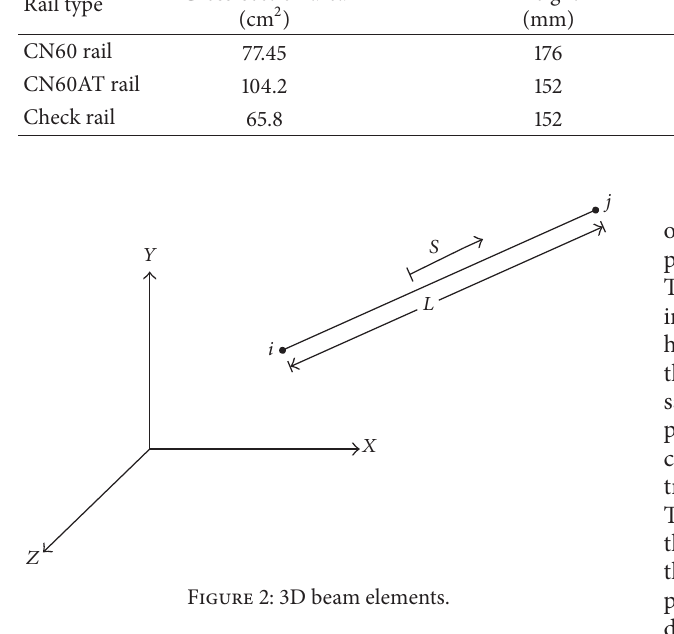
Figure 2: 3D beam